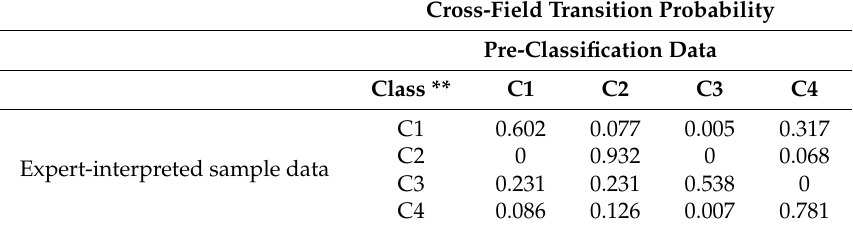
Table 2. Cross-field transition probability matrix from classes of the expert-interpreted dataset to classes of the pre-classified data by the object-based classification for the Cixi case study.